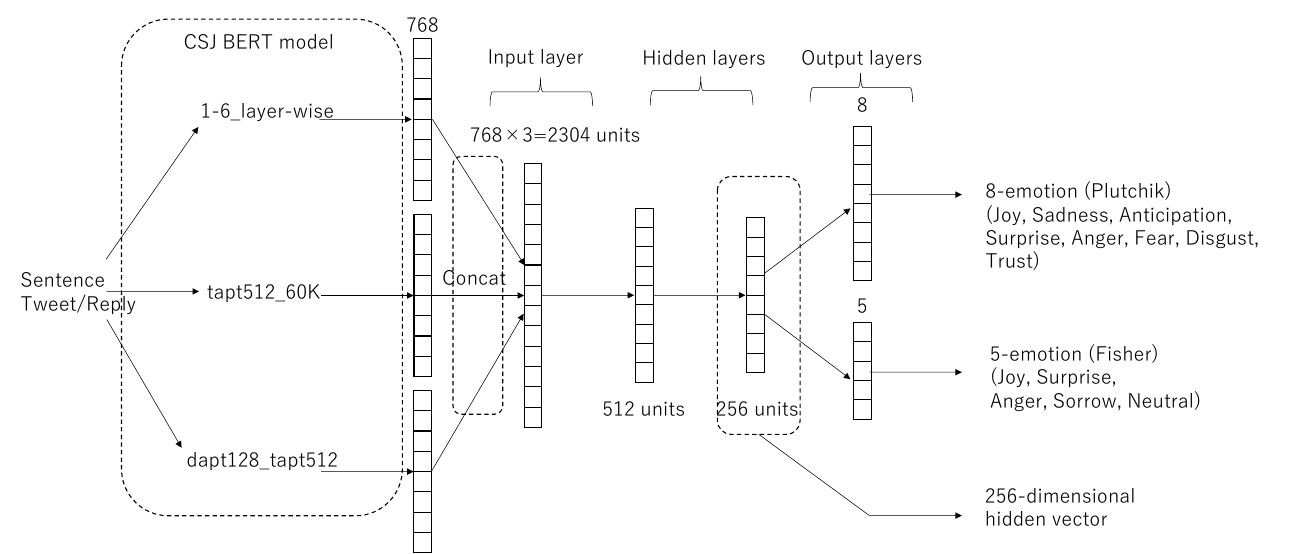
Figure 2. Emotion estimation network that outputs two types of emotion classes based on multi- task learning.